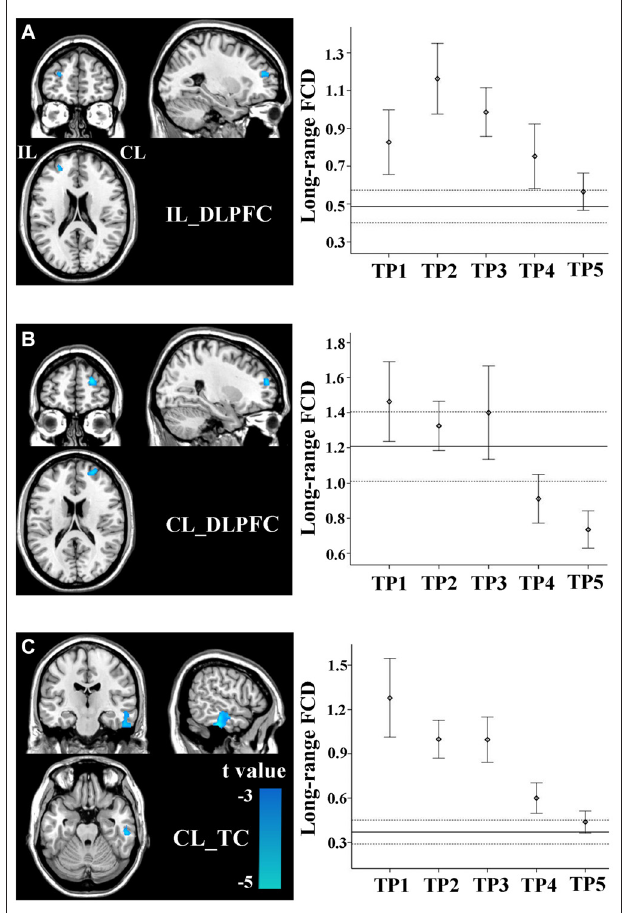
FIGURE 4 | Linear changes in FCD of the non-sensorimotor regions in stroke patients . The ipsilesional DLPFC (A) , contralesional DLPFC (B) , and contralesional temporal cortex (TC) (C) exhibit linear decreases in long-range FCD after stroke. The solid and dashed lines demonstrate the mean and standard error of the FCD in normal controls, respectively. Error bars illustrate the standard error. CL, contralesional; DLPFC, dorsolateral prefrontal